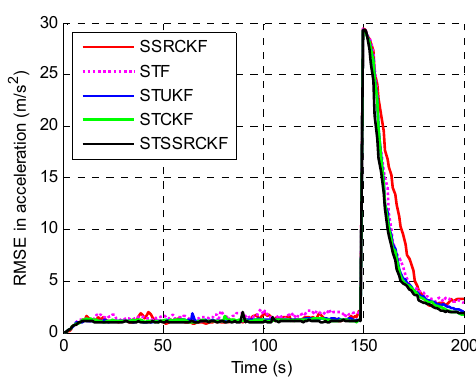
Figure 3. RMSE of the estimated acceleration.